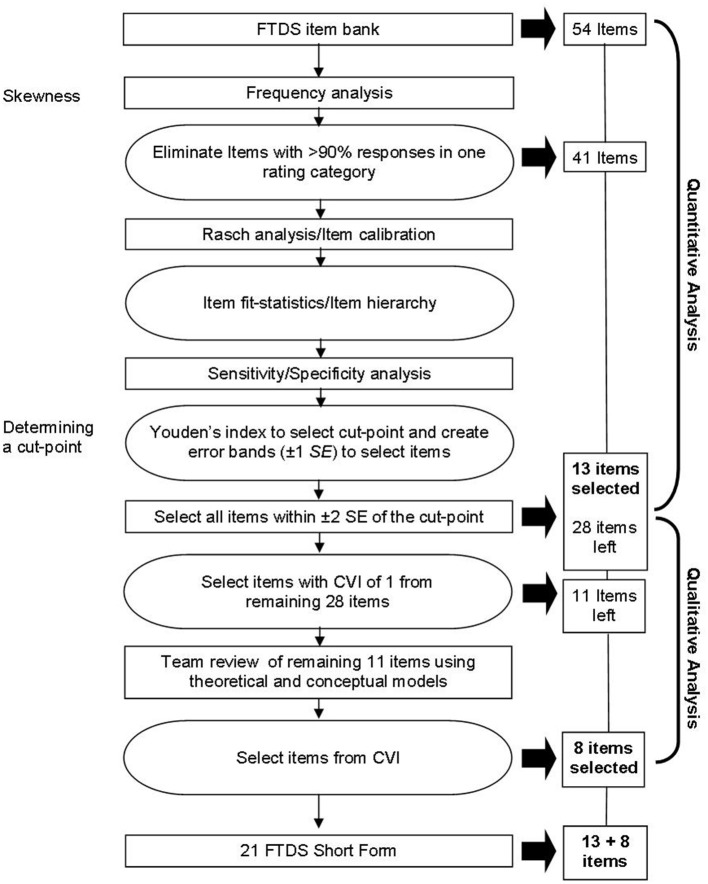
Flowchart of the procedures for constructing the Fitness-to-Drive Screening Measure Short-Form. FTDS, Fitness-to-Drive Screening measure; SE, Standard error; CVI, Content validity index.